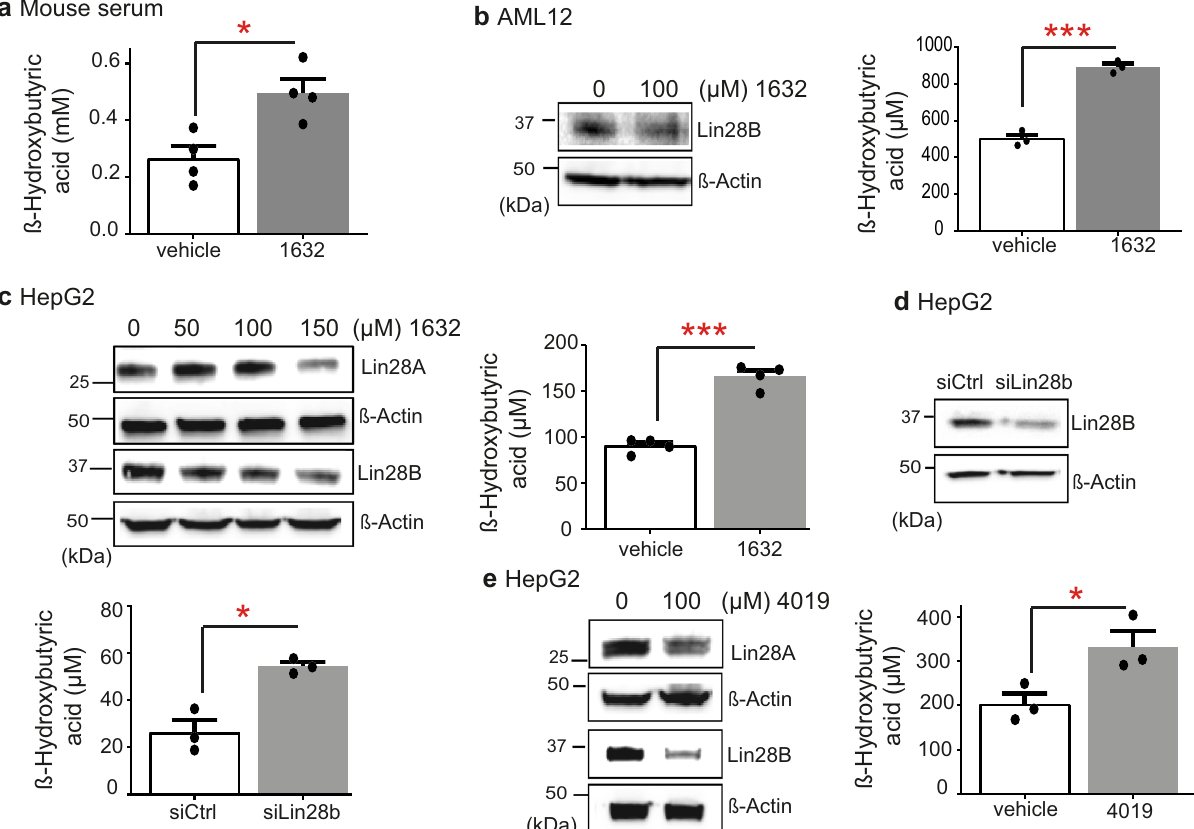
Fig. 2 | The small molecule Lin28 inhibitor C1632 promotes ketogenesis. a 7-week-old male C57BL/6J wild-type mice received intraperitoneal (IP) injections of C1632 (50mg/kg) or vehicle for 5 consecutive days, while mice were fed ad libitum . Serum β -OHB levels were measured in the indicated groups ( n =4 mice/ group, * P =0.0129). b AML12 cells were treated with 0 or 100 μΜ of compound C1632in thepresence of afattyacid (F.A.)mixtureofoleate andpalmitate for72h. β -OHBlevelsweremeasuredinthegrowthmediumofAML12cellsand β -OHBlevels were normalized to total protein of the corresponding samples ( n =3 biologically independent samples/group, *** P =0.0003). c HepG2 cells were treated for 4 days withC1632inthepresenceofaF.A.mixtureofoleateandpalmitate.Lin28A/Lin28B inhibition was examined by immunoblot analysis. β -OHB levels were measured in the growth medium of cells treated with vehicle or C1632 (100 μ M) and β -OHB levels were normalized to total protein of the corresponding samples ( n =4